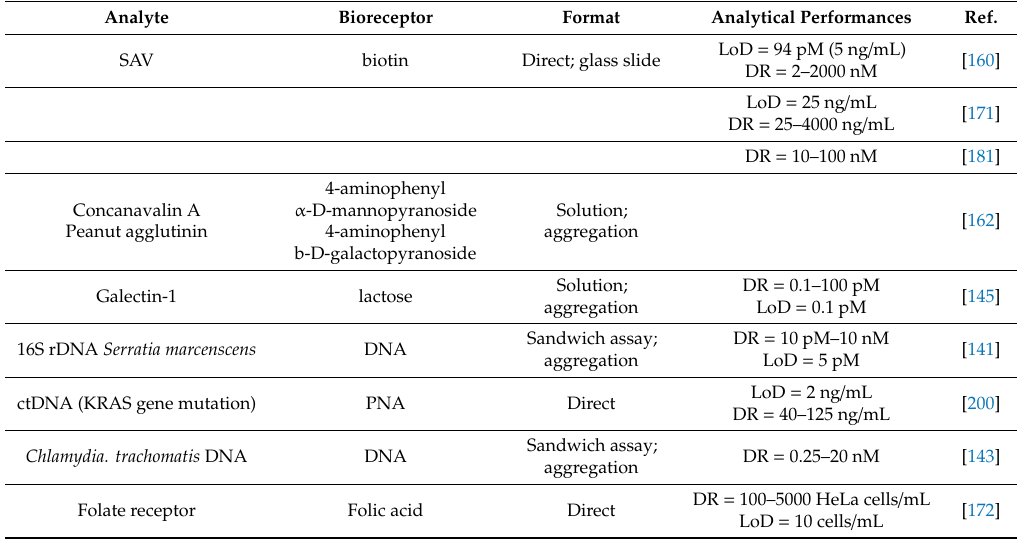
Table 7. Strategies, analytes, bioreceptors, and analytical performances for uncommon